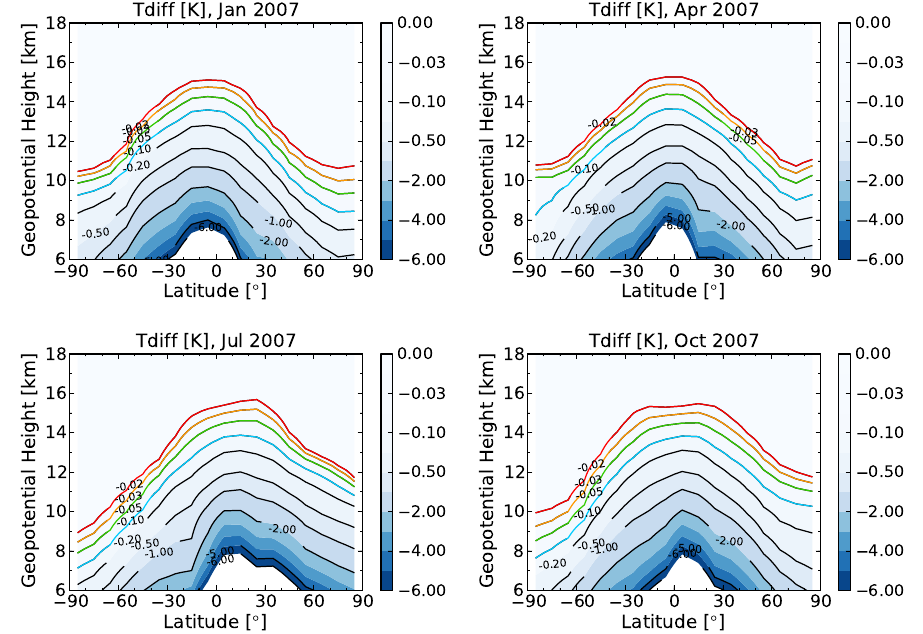
Figure 1. Difference between dry and physical temperature ( T diff ) for ECMWF mean climatological fields. January 2007 (top left), April 2007 (top right), July 2007 (bottom left), and October 2007 (bottom right). The colored lines mark T diff = − 0 . 1 , − 0 . 05 , − 0 . 03, and − 0 . 02